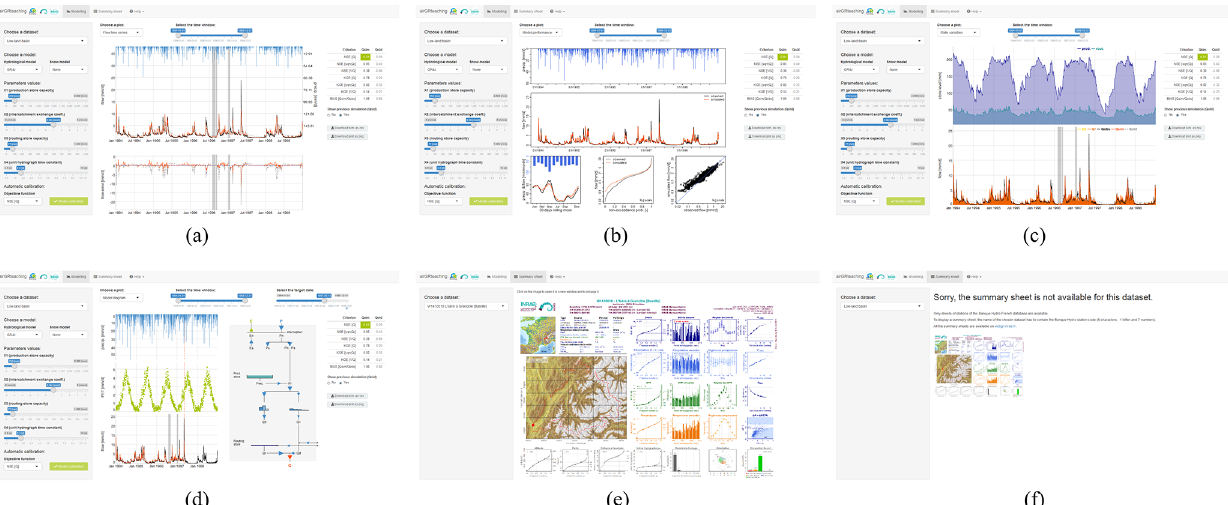
Figure B2. Graphical user interface of airGR using the airGRteaching package. (a) The time series of flow error (bottom graphic) and simulated and observed hydrographs (top graphic). (b) Performance graphics. (c) The time series of runoff components (bottom graphic) and reservoir levels (top graphic). (d) The interactive model diagram (right graphic) and the time series (left graphic) of precipitation, potential evapotranspiration, simulated flows and observed flows (from top to bottom). (e) Several hydrometeorological characteristics of the selected catchment. (f) When catchment characteristics are not